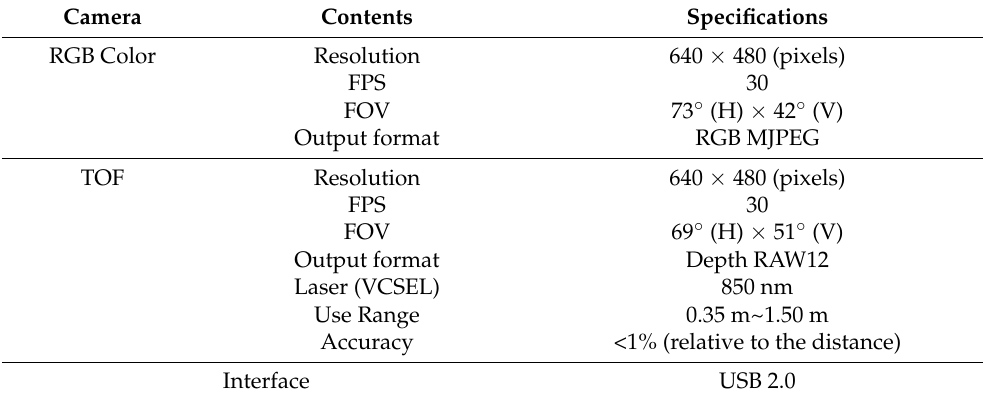
Table 2. Specifications of DCAM710.